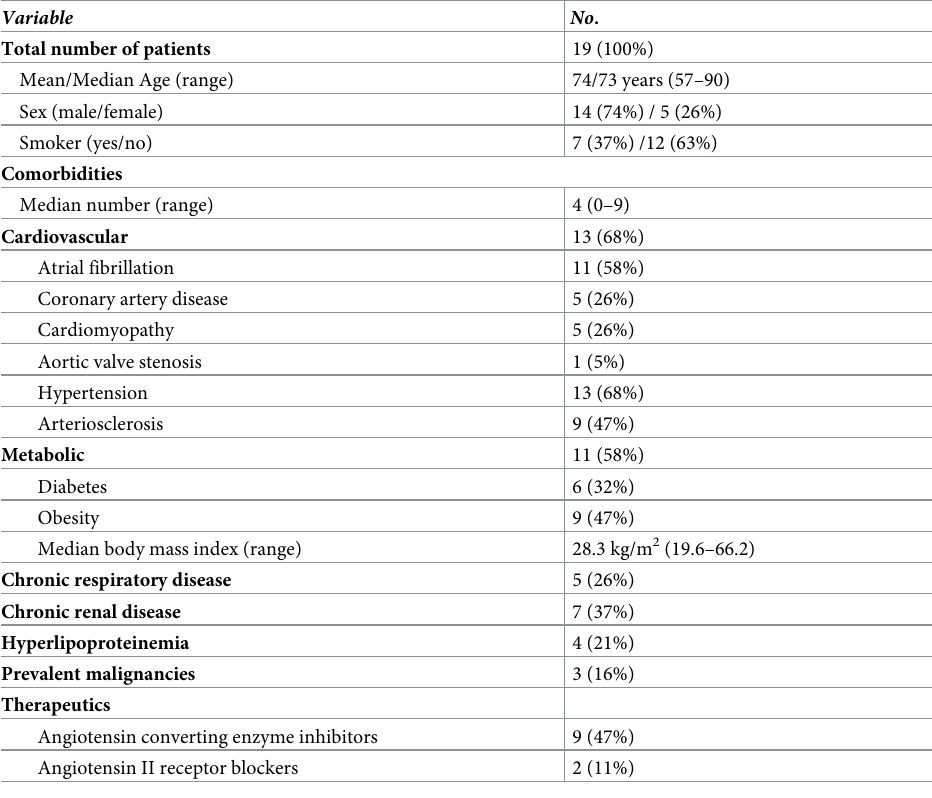
Table 1. Preexisting patients’ basic